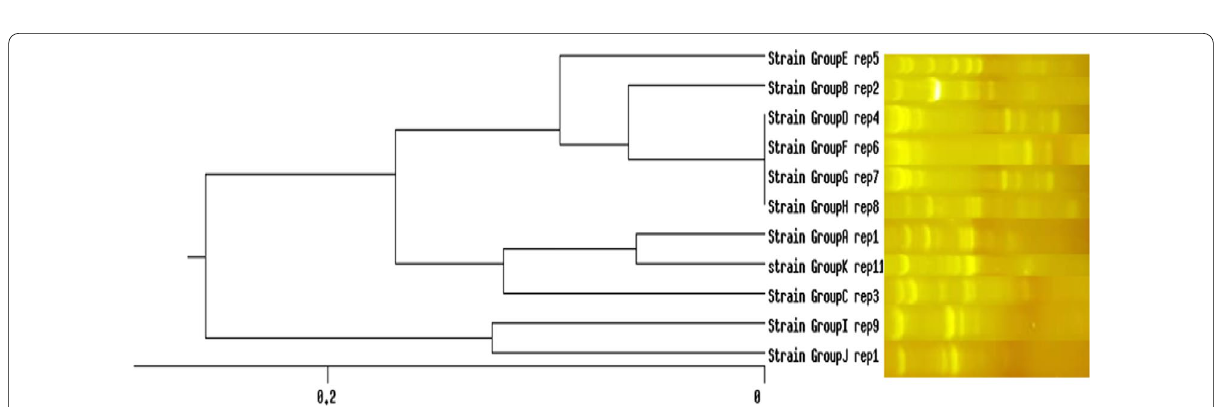
Fig. 3 A: Amplification plot of acrA and mrkA genes, B: melting curve analysis of acrA, mrkA and 16 S rRNA genes. The yellow, green and blue peaks represent the analysis of the melting curve of acrA genes with a melting point of 86 °C, mrkA gene with a melting point of 87.6 °C and 16 S rRNA with a melting point of 89 °C